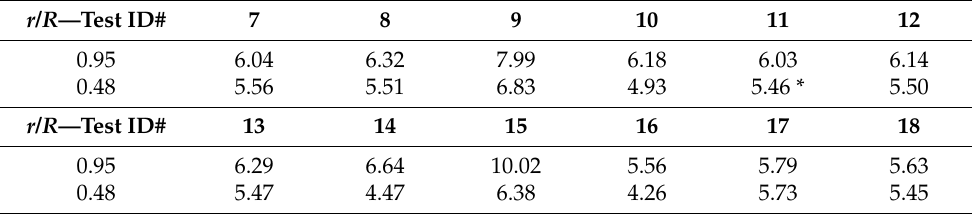
Table 4. Measured Ice Thicknesses t ice (in mm) of De-Icing Tests at r/R = 0.48 and r/R =